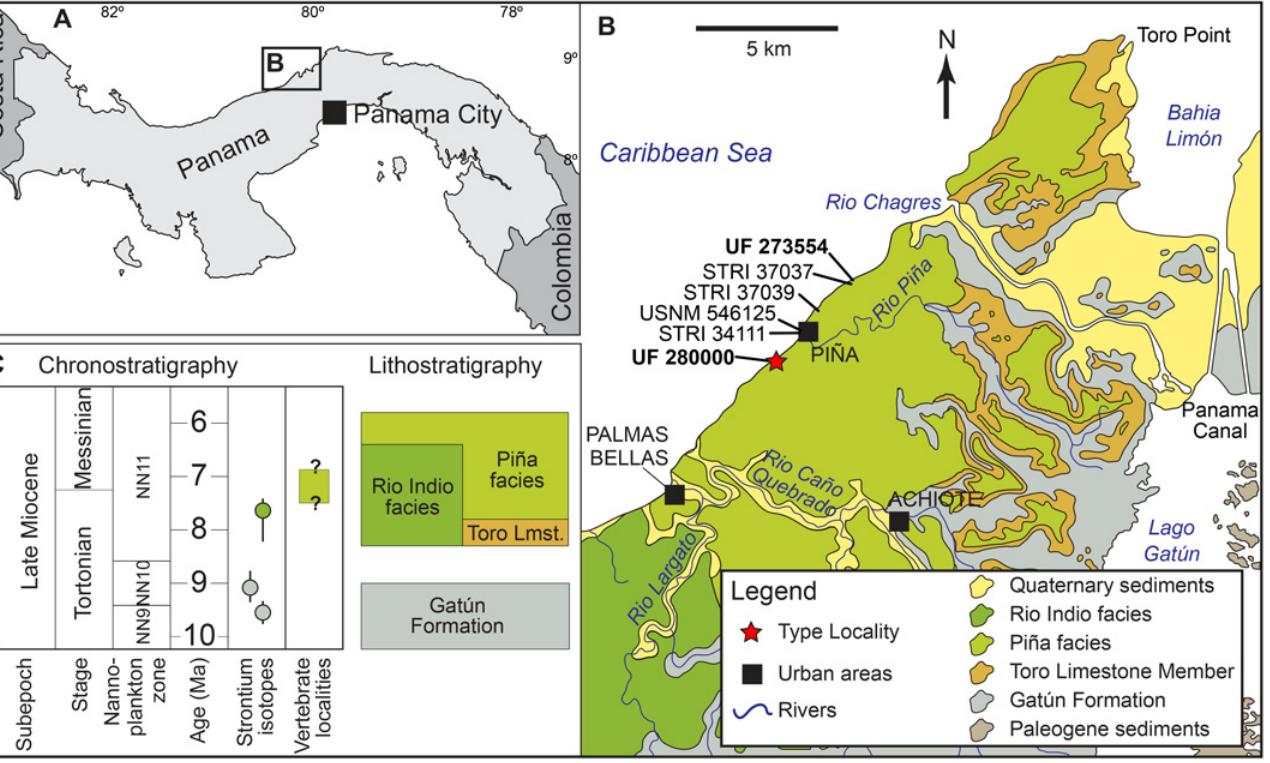
Fig 1. Locality map. A, map of Central America showing the localities. B, map of central Panama, showing the distribution of the Chagres Formation as well as the localities of fossil cetaceans mentioned in the text. C, chronostratigraphic and lithostratigraphic relationships of the Chagres Formation (modified from Hendy et al.